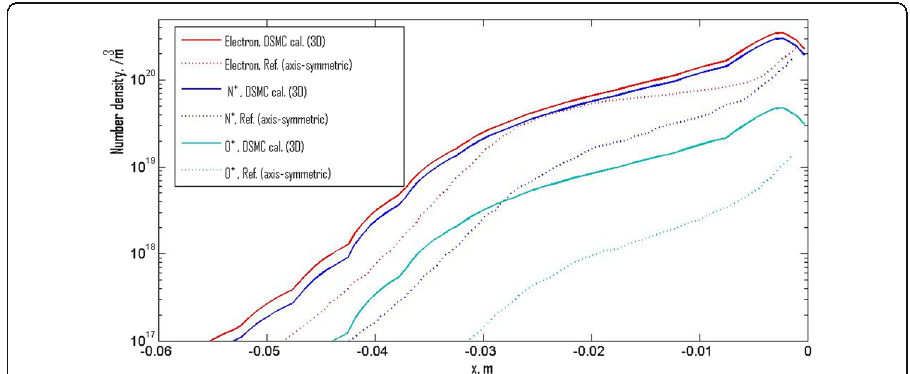
Fig. 14 Quantitative comparison of the electron, N + and O + density distributions along the stagnation line for the